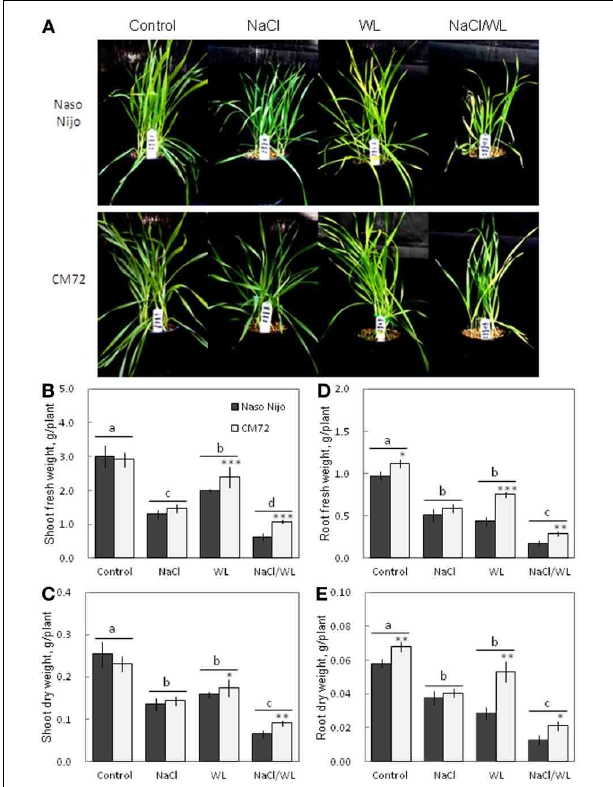
FIGURE 2 | Effects of separate and combined salinity and waterlogging stresses on growth of two contrasting barley cultivars in vermiculite. Dark bars, Naso Nijo; light bars, CM72. One-week old barley seedlings were subjected to one of four treatments: Control (no NaCl; well drained), NaCl (well-drained pots watered with 200mM NaCl solution), WL (submerged pots; no NaCl), NaCl/WL (pots submerged in 200mM NaCl solution). Plants were harvested for morphological (A) and biomass analysis (B–E) 14 days after the onset of treatment. For growth conditions and media composition, refer to the Materials and Methods section. Mean ± SD ( n = 5). Different lower case letters indicate the significant difference between treatments (averaged for both genotypes) at P < 0 . 01. Asterisks indicate the significant difference between cultivars within treatment at ∗ P < 0 . 01, ∗∗ P < 0 . 001, and ∗∗∗ P < 0 .